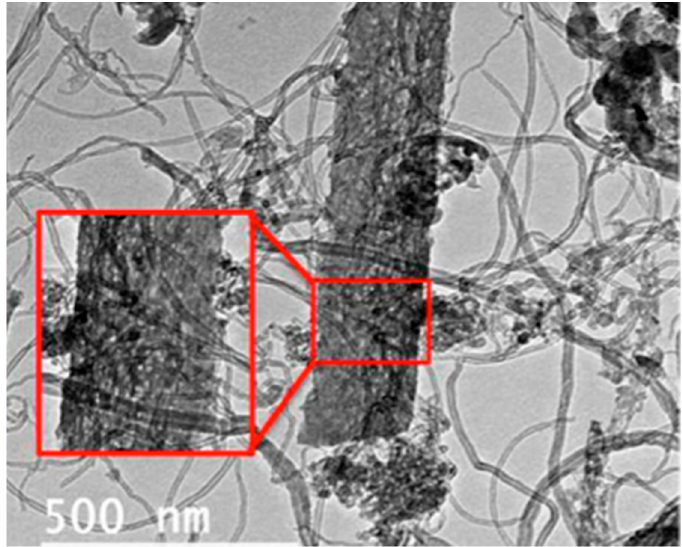
Figure 2. TEM micrograph of an intergrowth of carbon nanotubes with TiO 2 -B nanoribbons. Reprinted with permission from Ref. [76]. Copyright 2018, Springer Nature.